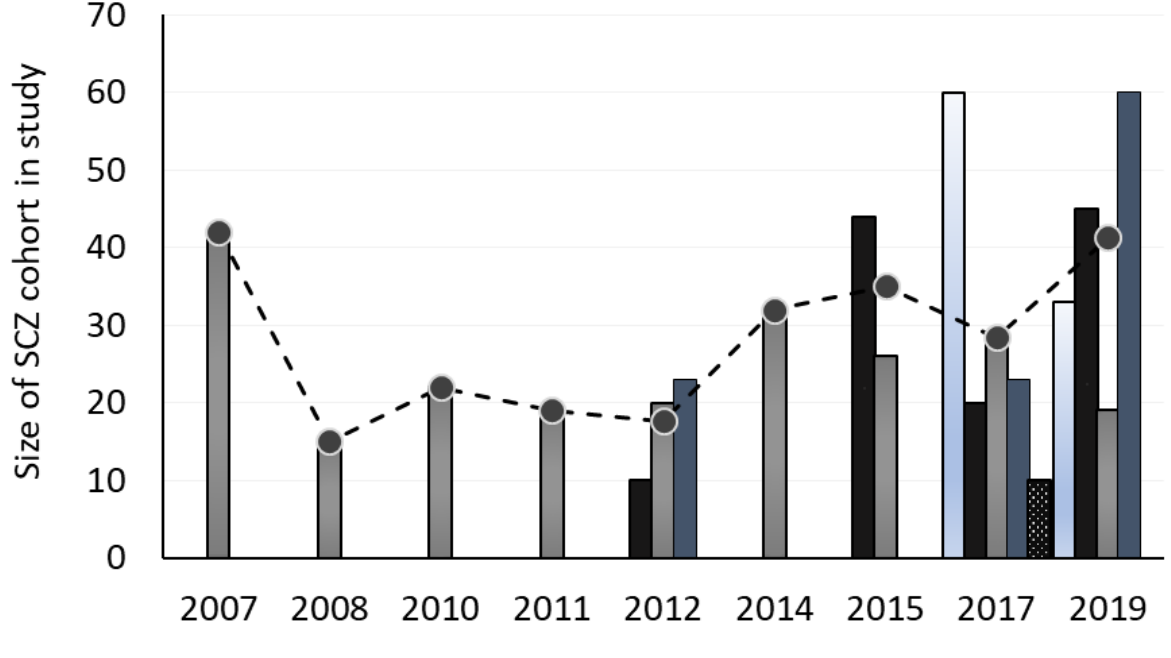
Figure 2. Publication frequency. The number of bars shown in the graphic reflects the number of articles published per year, and the height of each bar reflects the number of SCZ patients in the cohort of the study. The average number of SCZ patients in the cohorts per year is shown in the markers connected by the dashed line.